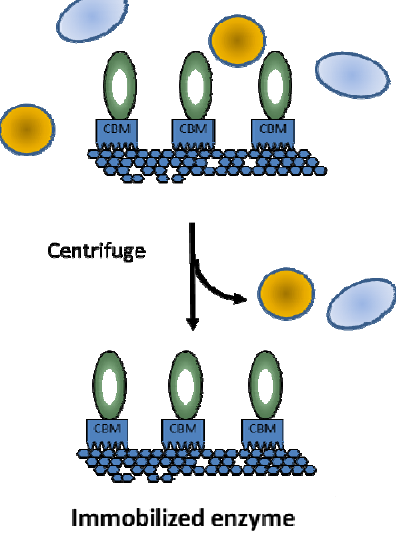
Figure 7. One-step protein purification and immobilization of a CBM-tagged protein on a cellulosic